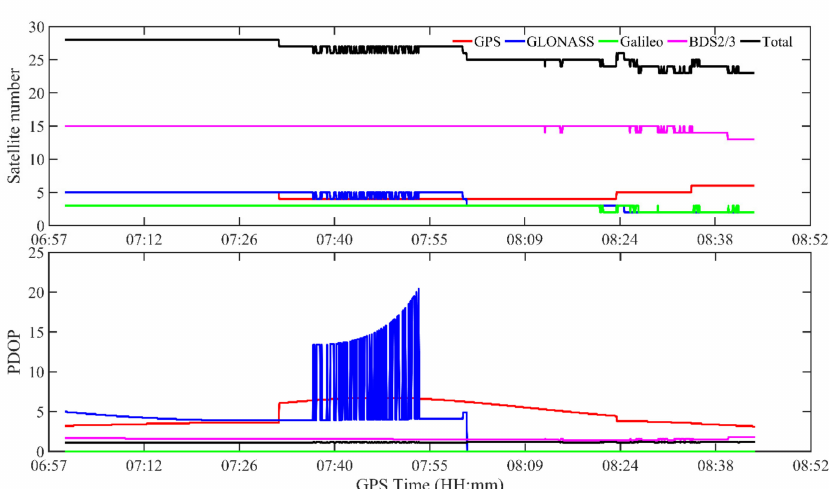
Figure A2. Satellite number (top) and Position Dilution of Precision (PDOP, bottom) during the experiment.